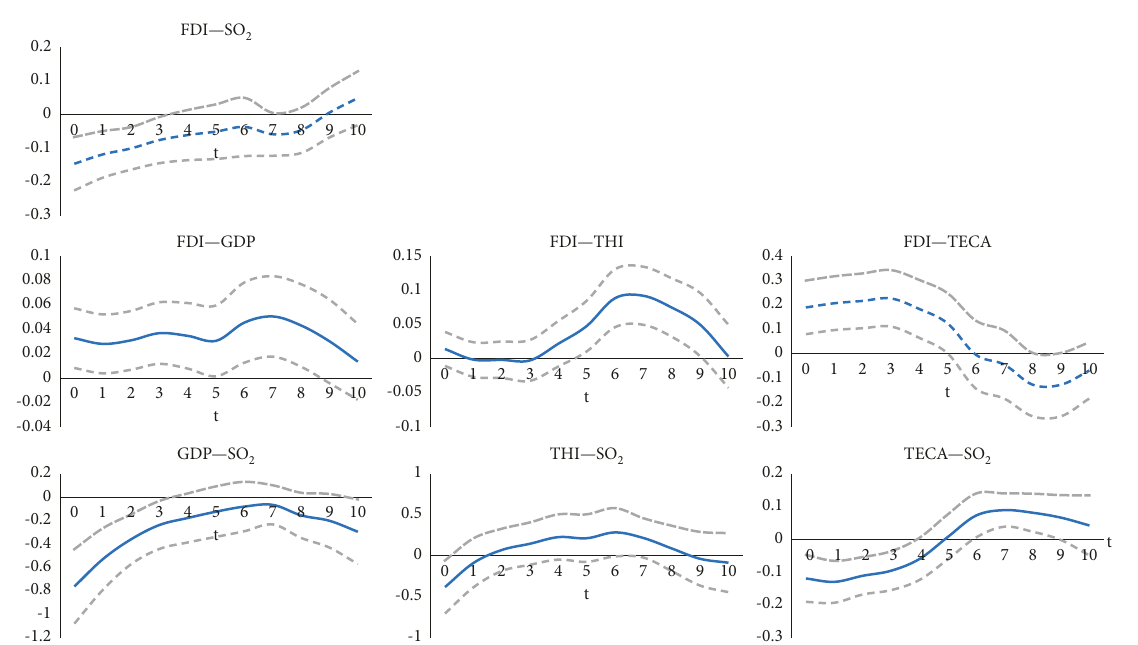
Figure 8: Change trend graph of influence effect among variables. Note: the ordinate is the influence coefficient. The blue solid line is the change trend of the influence effect, and the gray dotted line is the confidence interval. We performed pairwise OLS regression on the variables. The control variables include a series of control variables including the unemployment rate of each province, total capital formation, consumption expenditure, the proportion of students in colleges and universities per 100,000 population, and the area of urban garden green space. It is also derived from the China Statistical Yearbook and controls for time fixed effects and regional fixed effects.